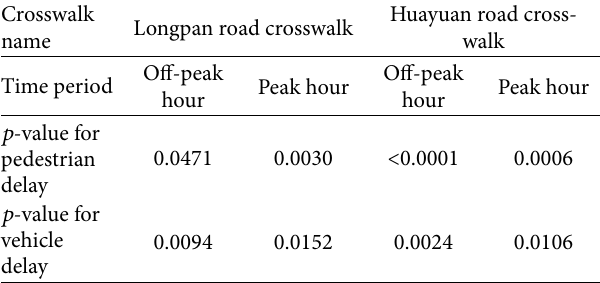
Table 2: Paired 𝑡 -test results under a significance level of 0.05. Crosswalk